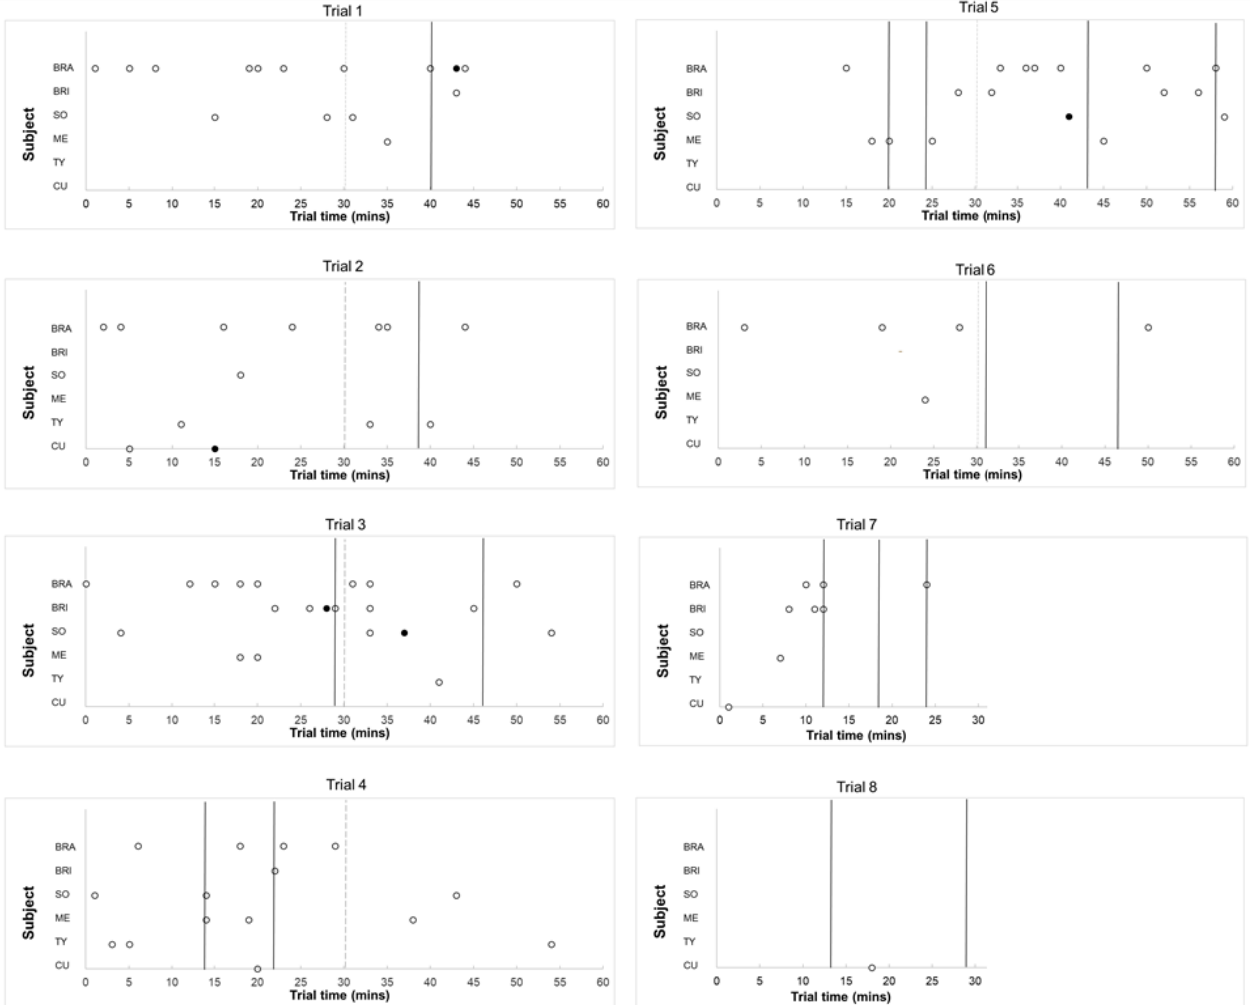
Figure 2. Occurrence of 106 underwater bubble bursts (open circle = 1 burst, closed circle = 2 bursts) and task successes (vertical solid lines) by dolphins over eight trails. Dolphin names are abbreviated to their first 2–3 letters. Bursts and successes are plotted within 1-min intervals. Trials 1–6 (rubber task ball) consisted of two 30-min half-trials, separated by a 15-min break (vertical dashed line). Trials 7–8 (gelatine task ball) consisted of one 30-min half-trial